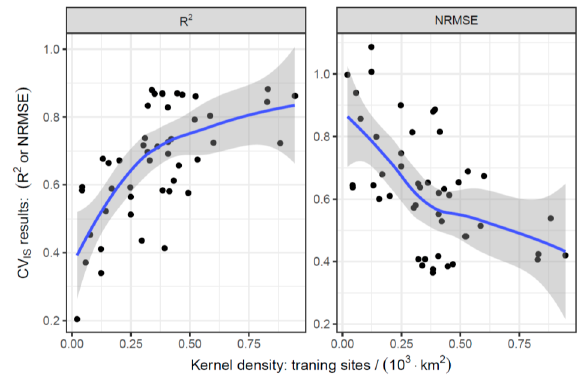
Figure 5. Different performances of CV IS for the final estimator (PM 2.5Optimal ) by density of training sites, estimated by a two-dimensional Kernel with a bandwidth of 50 kilometer. The blue curves and grey ribbons present the LOESS smoothing trends with corresponding confidence intervals.